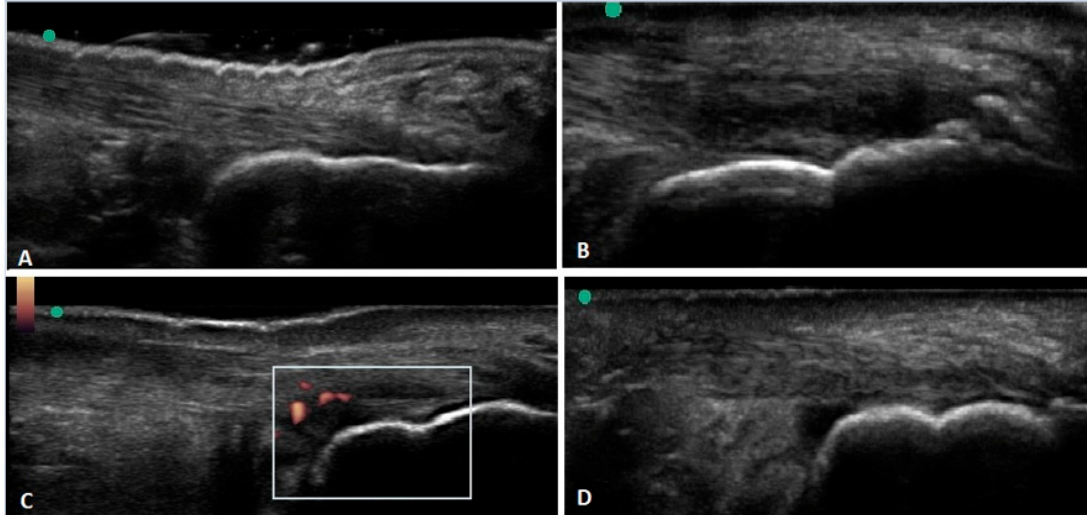
Figure 2. Ultrasound imaging of Achilles tendon. Figure 2 illustrates several examples of ultrasound findings in the posterior ankle and hindfoot. ( A ) Normal imaging of hindfoot / posterior ankle. ( B ) Insertional Achilles calcific tendonopathy. ( C ) Intrasubstance Achilles tear with surrounding neovascularization. ( D ) Retrocalcaneal bursitis. Note the green dot indicates probe orientation. The box in C is the color box indicating the region of color Doppler assessment.